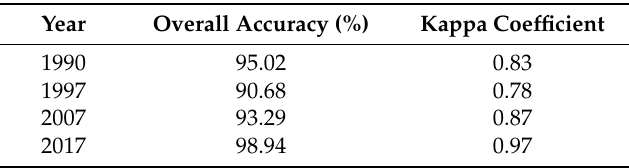
Table 3. Accuracy assessment of LCZ